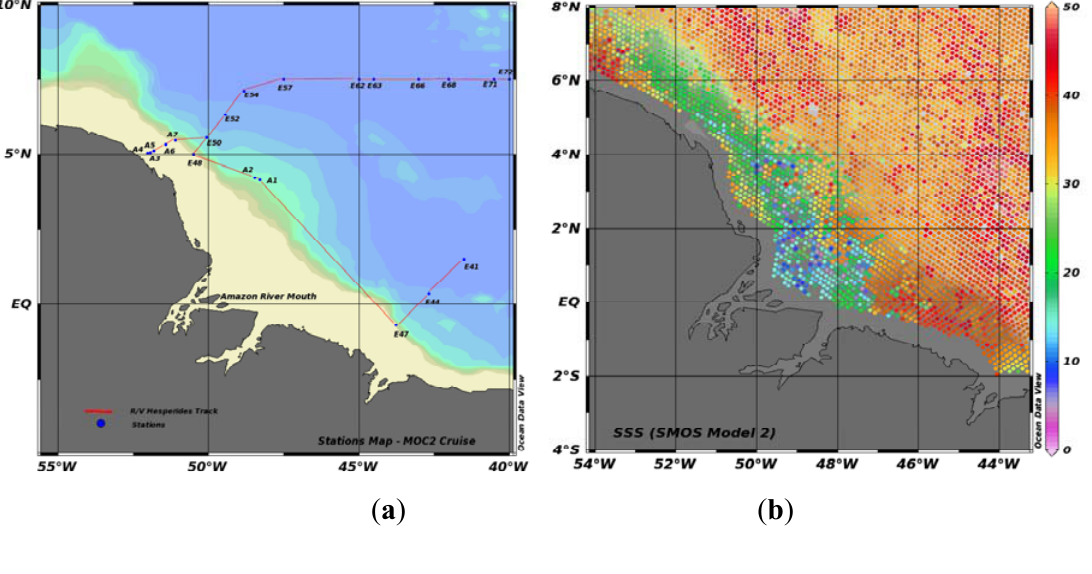
Figure 9. ( a ) Track of the Hespérides research vessel; ( b ) SMOS-derived sea surface salinity blue), and the three outputs from the SMOS L2 ocean salinity processor (red: SSS 1, two-scale model; green SSS2, SSA model; and light blue SSS3 semi-empirical model) (from